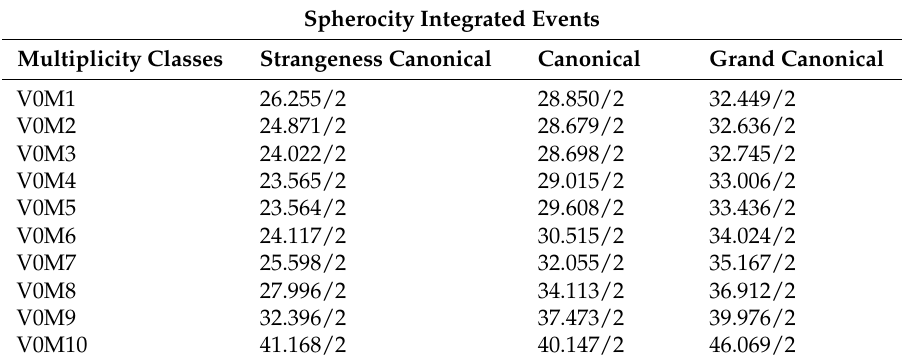
Table 4. χ 2 /NDF of the fits for spherocity integrated events in different multiplicity classes for pp collisions √ s = 13 at